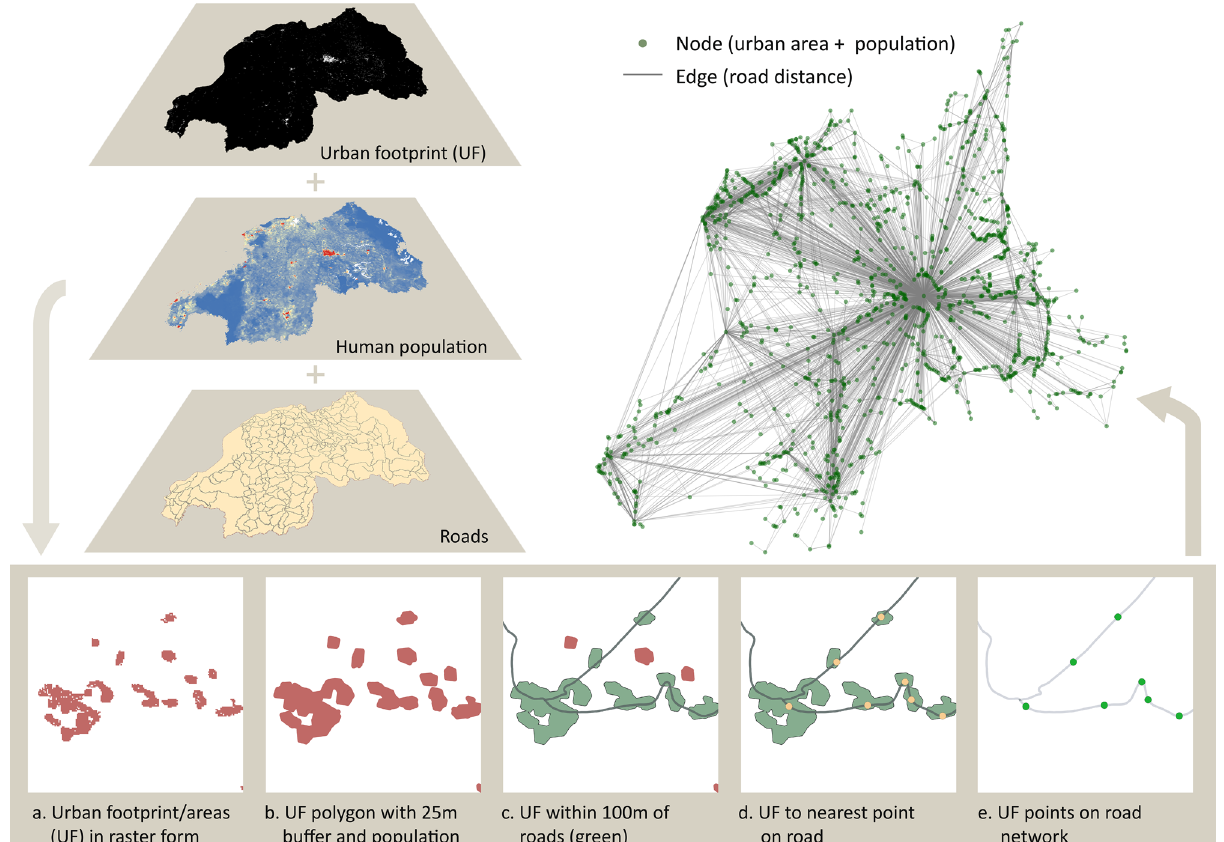
and roads 15 ) were combined to form a network. ( a ) Section of urban footprint (UF) layer in raster form. ( b ) Conversion of the UF raster to polygon with added population information and 25 m buffer. ( c ) Subset urban areas that are near roads (100 m including the buffer). ( d ) Conversion of urban areas into points on the